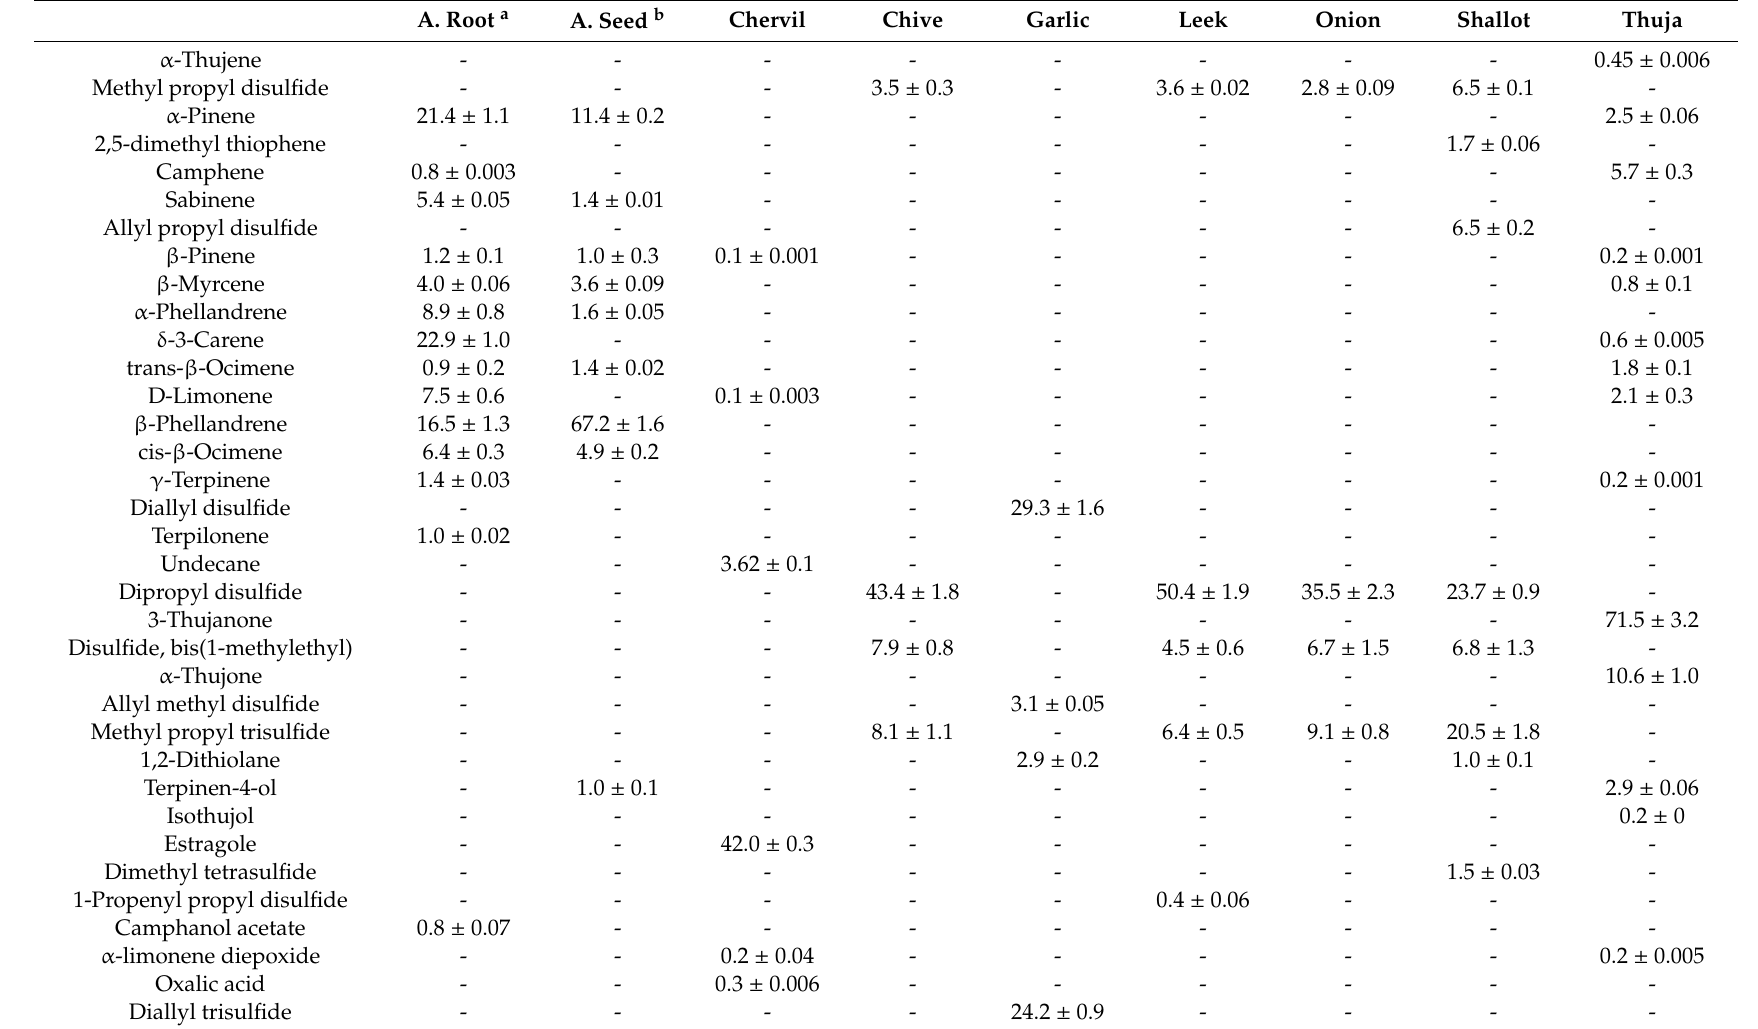
Table 1. Relative chemical composition of the 9 tested